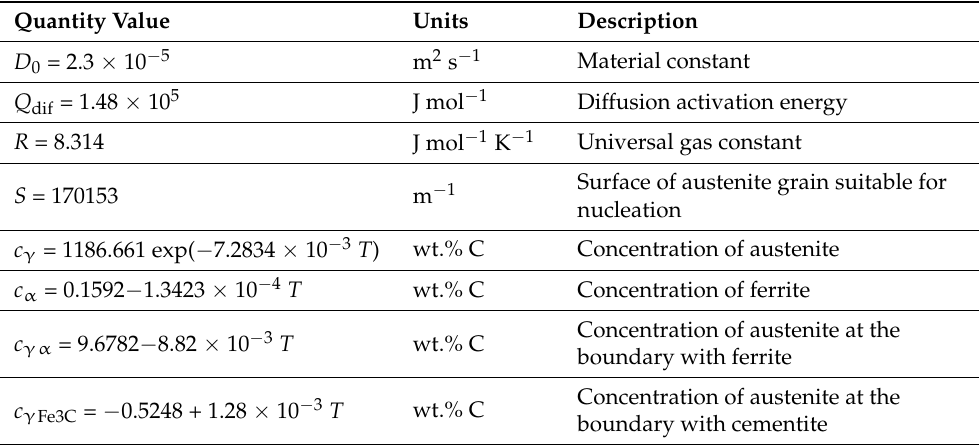
Table 3. Physical quantities used in modelling of austenite isothermal decomposition. Quantity Value Units Description